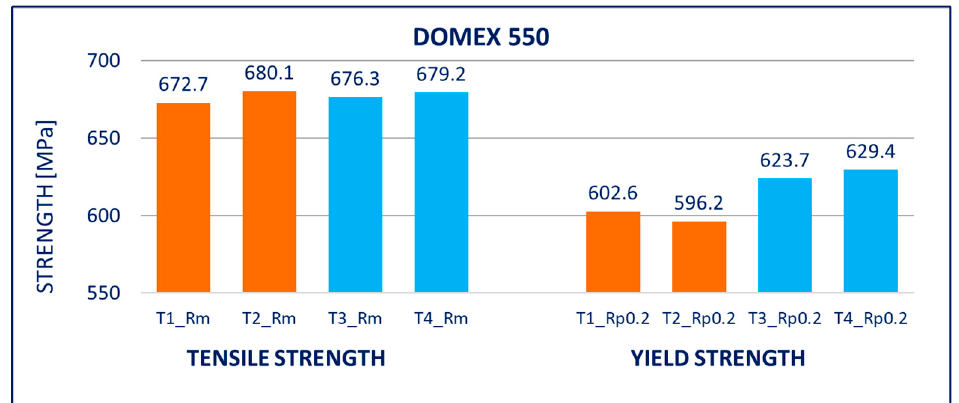
Figure 6. Tensile tests of specimens from DOMEX 550 steel. Description of specimens: T1 and T2 are groups of specimens without zinc coating; T3 and T4 are groups of specimens after hot-dip galva- nization. R m is tensile strength, R p0.2 is yield strength.